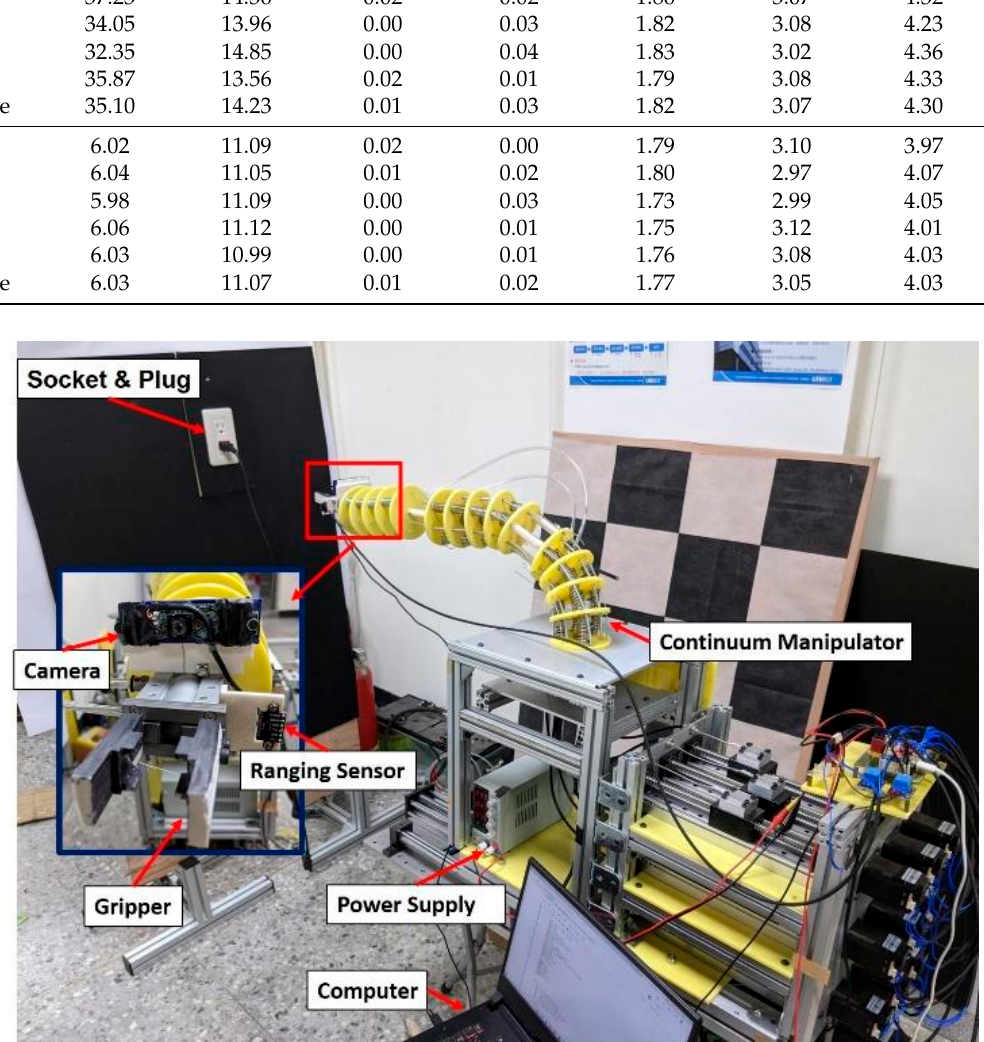
Figure 17. Environment for the plugging/unplugging experiment.